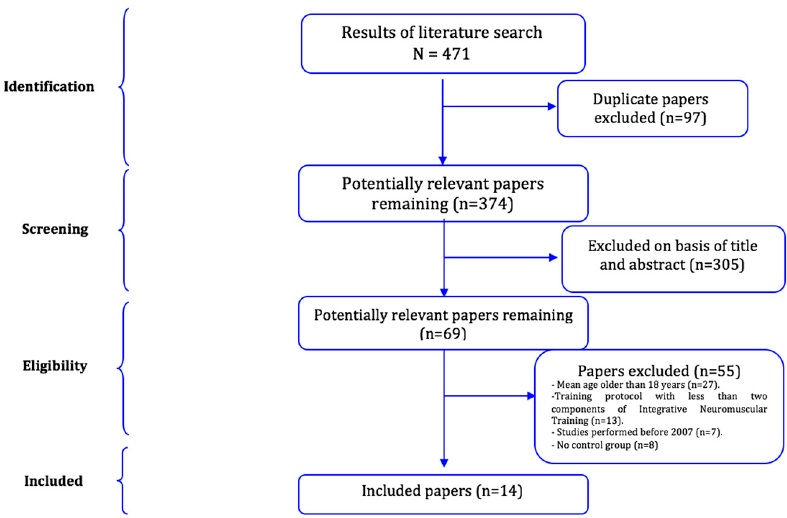
Figure 1. Flow diagram of the search process of integrative neuromuscular training e ff ects in injury prevention and performance on youth athletes. 112